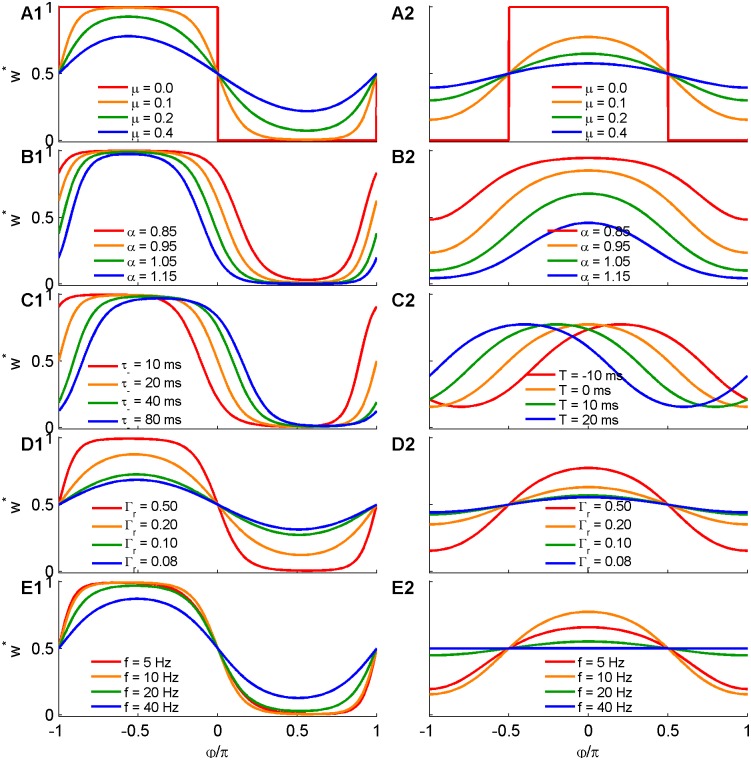
The asymptotic synaptic weight in the case of single synapse STDP.The different panels show the resultant synaptic weight profile w*(φ) given by eqs (12) and (13) as a function of the pre-post phase difference, φ, for different sets of parameters. A1-E1 (left column) show the results for the exponential STDP kernel, as in Fig 1C. A2-E2 (right column) show the results for the difference of Gaussians STDP kernel, as in Fig 1D. The different colors show the variation of the asymptotic weight with respect to a single parameter of the STDP-driven synaptic dynamics that is being varied. In A1 and A2 the different colors depict different values of μ. In B1 and B2 the different colors depict different values of the relative strength of depression α. In C1 and C2 the different colors are for different time constants of the STDP rule τ− and T, respectively. Panels D1 and D2 show the effect of the relative strength of the oscillatory activity Γr, see eq (8). Panels E1 and E2 show the effect of the oscillation frequency f. In all panels, unless stated otherwise in the legend the following parameters were used: α = 1, μ = 0.1, ν = 2π · 10Hz, and Γr = 0.5, for the exponential STDP kernel (left column) τ+ = τ− = 20ms was used, and for the Gaussian STDP kernel (right column) T± = 0 and τ+ = 20ms, τ− = 30ms were used.